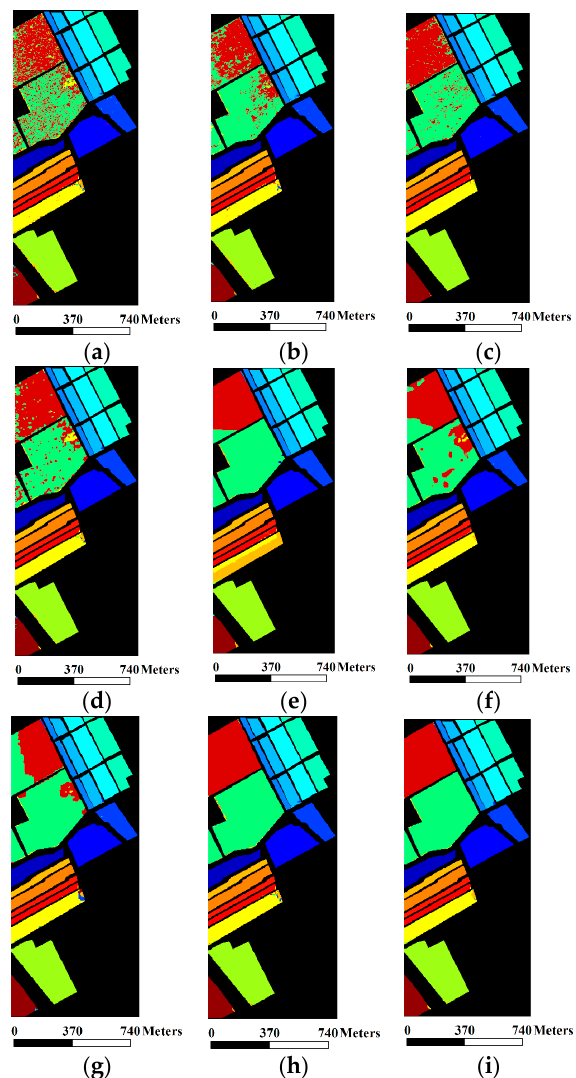
Figure 7. Classification maps for the Salinas data set by different methods: ( a ) SVM; ( b ) SS-Kernel; ( c ) EMP; ( d ) EPF_JBF; ( e ) MLR-LORSAL; ( f ) LBP-AL; ( g ) LORSAL-AL-MLL; ( h ) CS-GC; and ( i ) CS-GC + JBF.